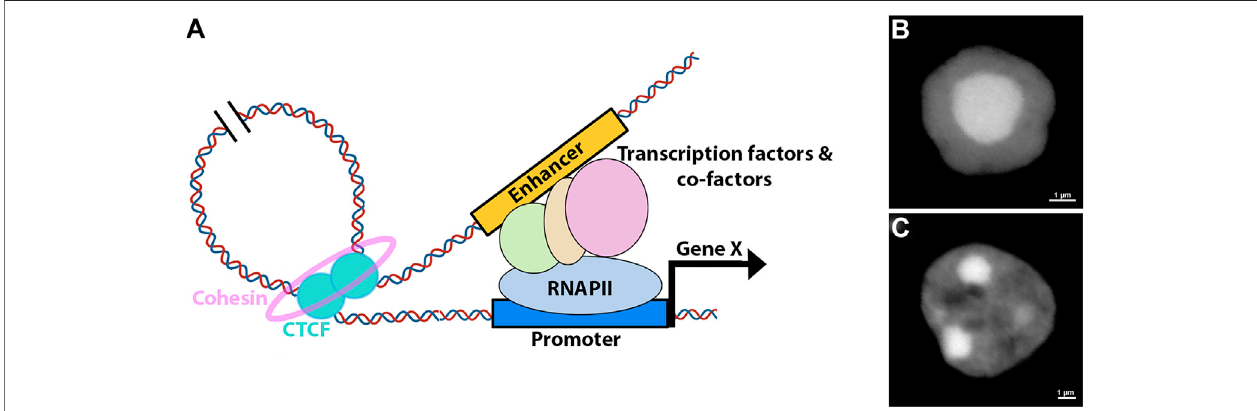
FIGURE 2 | Retinal 3D nuclear organization. (A) Model for enhancer-mediated activation of gene expression. The process involves formation of a DNA loop, facilitatedbytherecruitmentofCTCFandcohesin,thatbringsdistalenhancersintoproximityofthepromoters.Enhancersenabletherecruitmentoftranscriptionfactors, co-factors and transcriptional machinery to the promoter. (B , C) Nuclear structure of murine rod (B) and bipolar (C) cells as revealed by DAPI staining.